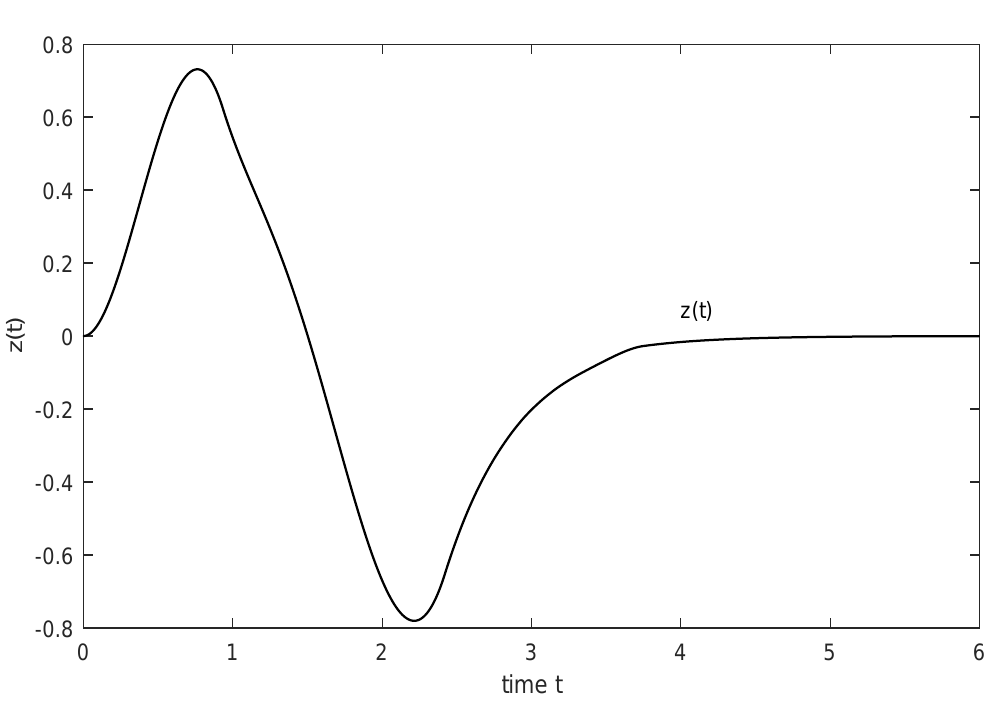
Figure 1. The trajectory of z ( t ) of the system in Equation